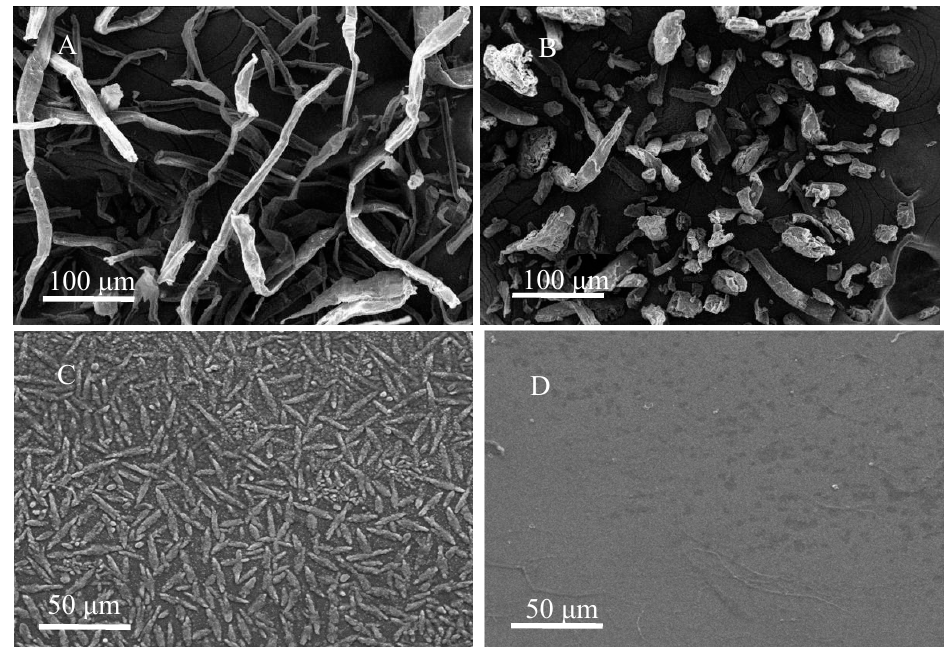
Figure 2. Cellulose samples micromorphology. ( A ) wood cellulose (WC), ( B ) microcrystalline cellulose (MCC), ( C ) cotton cellulose nanofiber (C-CNF), ( D ) wood cellulose nanofiber (W-CNF).